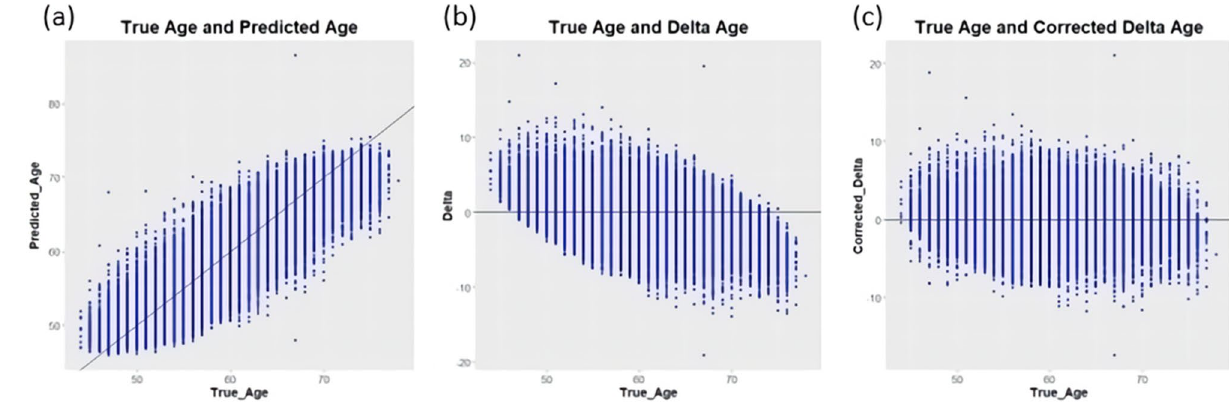
Figure 2. Scatterplots of chronological age (x-axis) vs. ( a ) predicted age, ( b ) delta age, and ( c ) bias-adjusted delta age